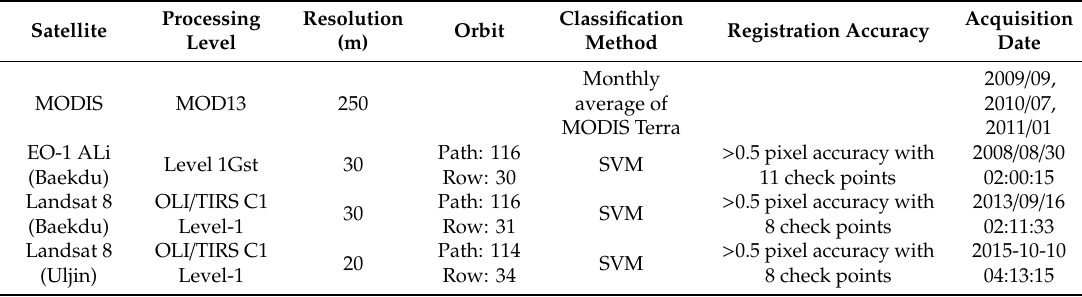
Table 3. Processing information of Landsat and EO optical images which were employed for the validation.